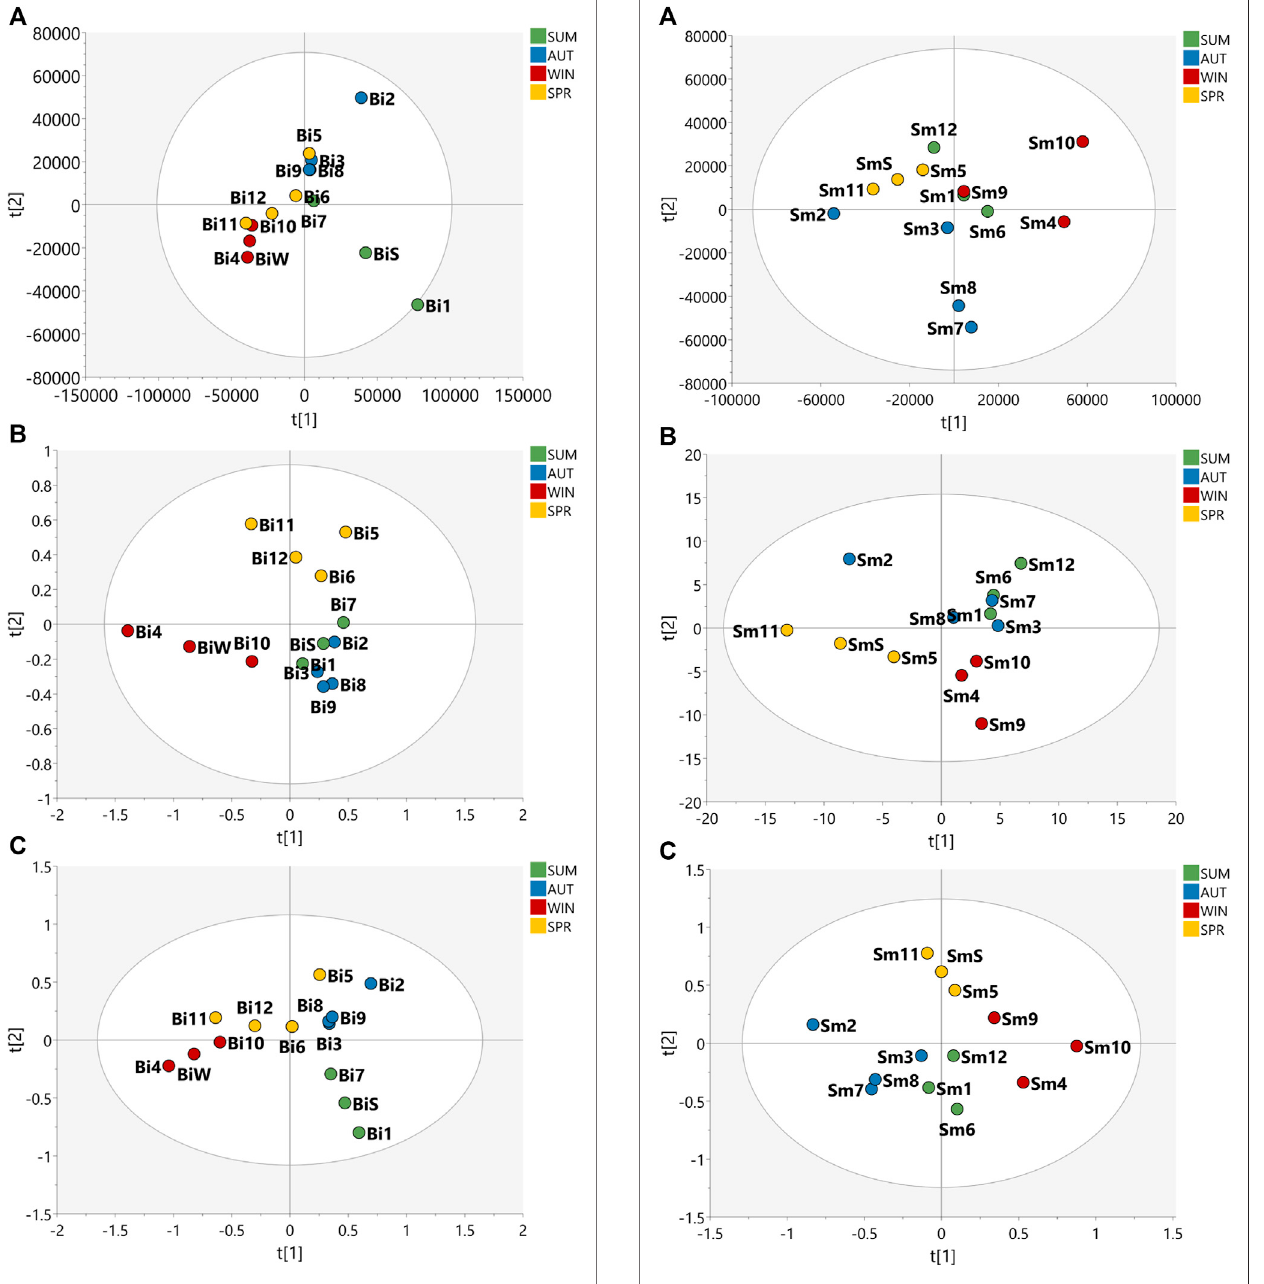
distinct groups, especially for summer and winter samples. In Figure 1A , clustering was performed according to HRMS data and it is apparent that the spring samples presented an intermediate MS pro fi le between winter and autumn seasons; in Figure 1B , for the J -res data, summer and